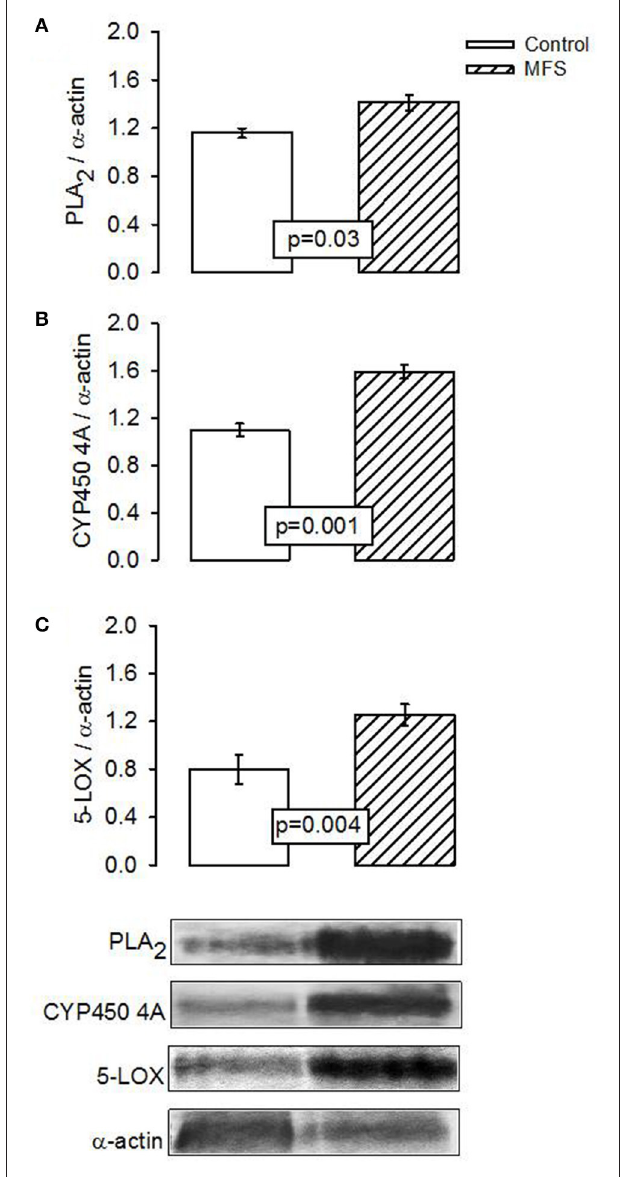
FIGURE 3 | Representative image of the densitometric analysis of Western blots of (A) PLA2, (B) CYP450 4A, and (C) 5-LOX protein expressions in aortic aneurysm homogenate the control subjects ( n = 6) and MFS patients ( n = 14). Values are means ± SE. FIGURE 4 | Representative image of the densitometric analysis of Western